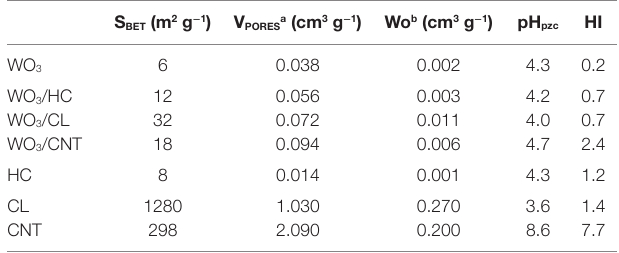
TaBle 1 | Main textural parameters obtained from gas adsorption data and surface chemistry parameters of the studied materials (semiconductors, carbon materials, and semiconductor/carbon